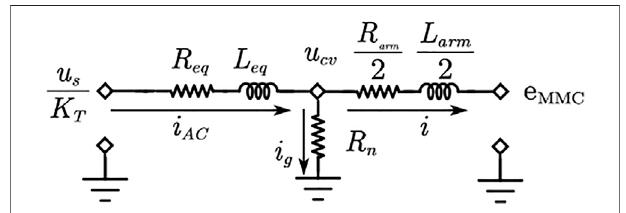
FIGURE 3 | Equivalent circuit of AC system.